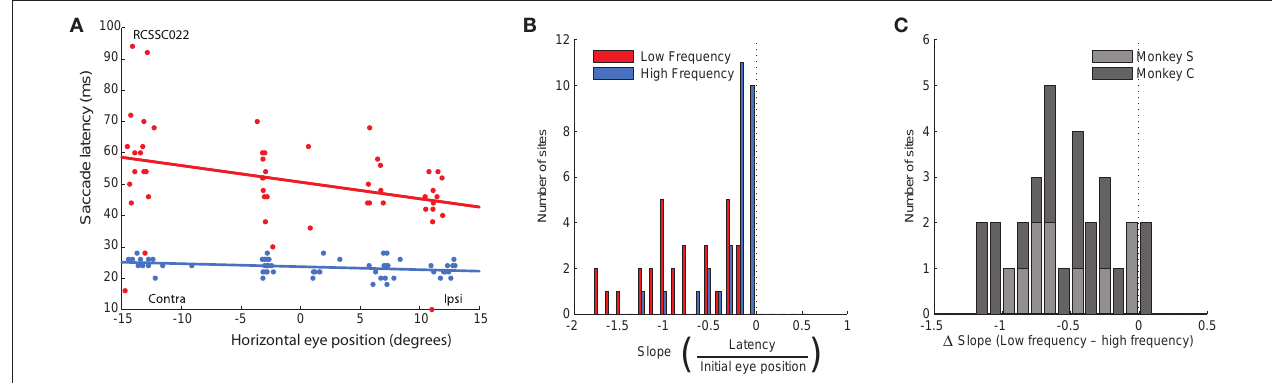
FIgure 7 | Population analysis of the effect of initial eye position on saccade latency. (A) An example site (same as Figure 2D ) showing the increased latency for contralateral initial fixation positions, primarily for low frequency stimulation (red). (B) Magnitude of slopes obtained from linear regression of saccade latency on initial eye position for each stimulation site. Data are shown for low (red) and high (blue) frequency stimulation conditions. Negative slope indicates longer latency for more contralateral fixation positions. (C) Differences in slope between low and high frequency